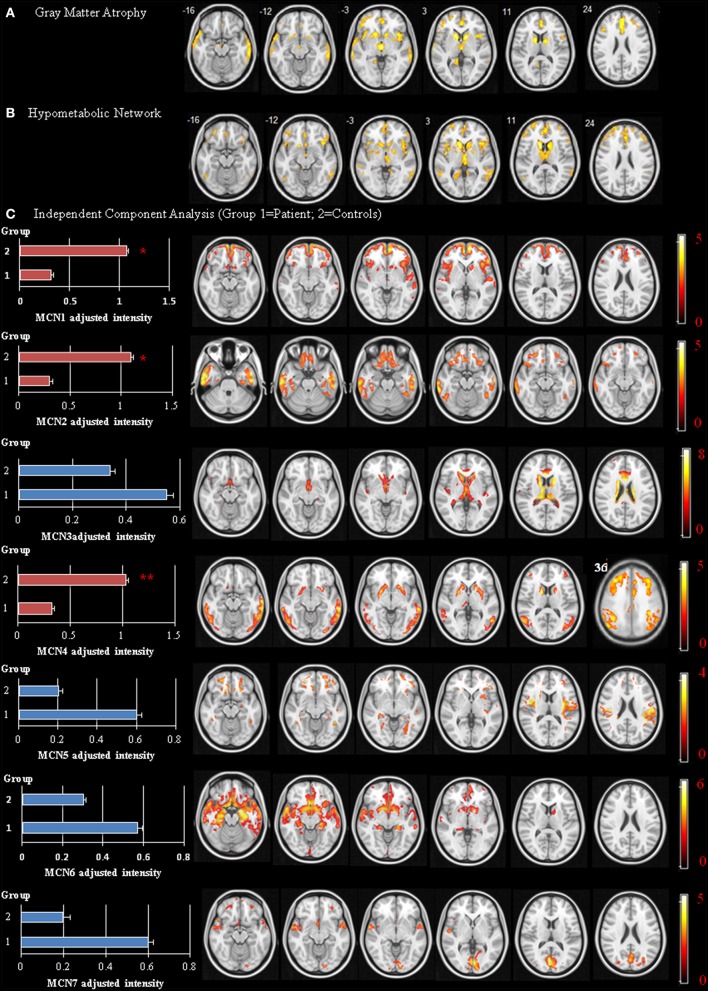
Disease-specific network showing significant differences between the patients and controls. Voxel-based morphometry of gray matter (GM) volume (A) and positron emission tomography (PET) signals using occipital cortex as reference region (B) Independent Component Analysis of PET (C) Image results overlay on the T1 template and color bar represents t-value ranges. MCN, metabolic covariant network. *p < 0.05, **p < 0.01.